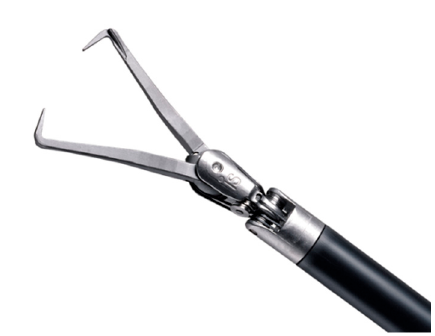
Figure 4. The sharp and powerful long jaw of the robotic Tenaculum forceps (© (2020) Intuitive Surgical, Inc. Used with permission) [34].